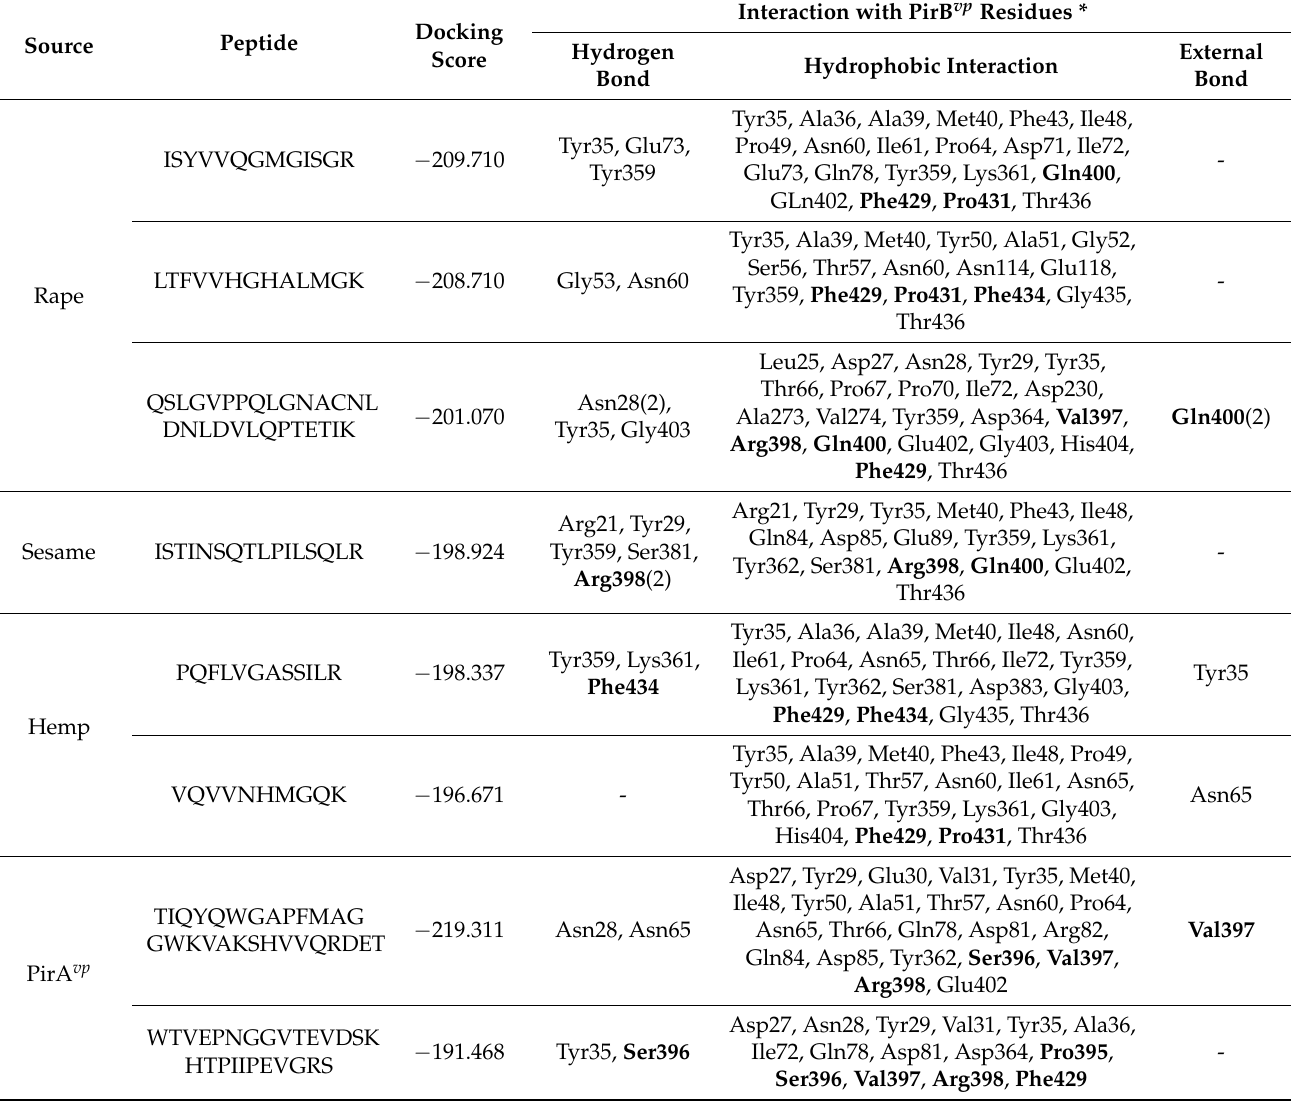
Table 5. Docking scores for interactions between six best-scored oilseed peptides and PirB vp , with details on the PirB vp residues involved in different types of